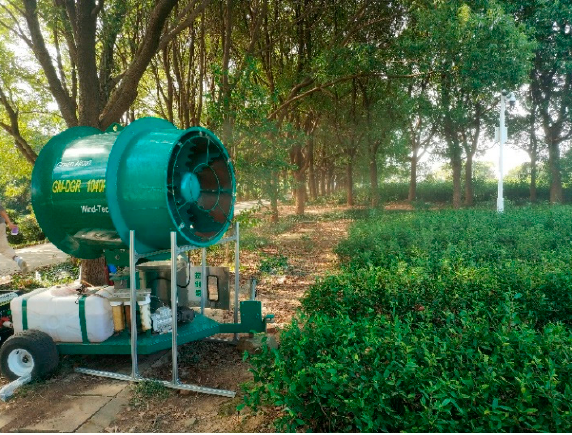
Figure 15. Construction site of spray cooling